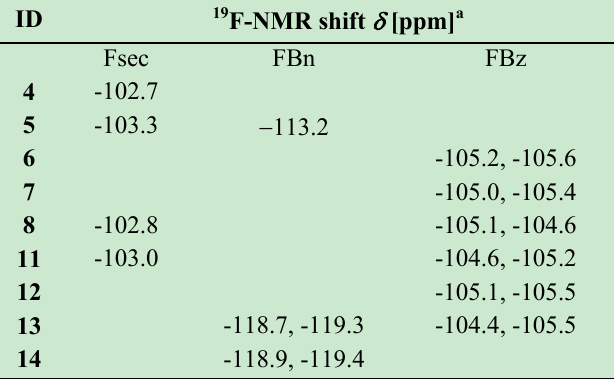
Table 2. 19 F-NMR shifts for the fluorinated protecting groups in compound 4 - 8 and 11 - 14